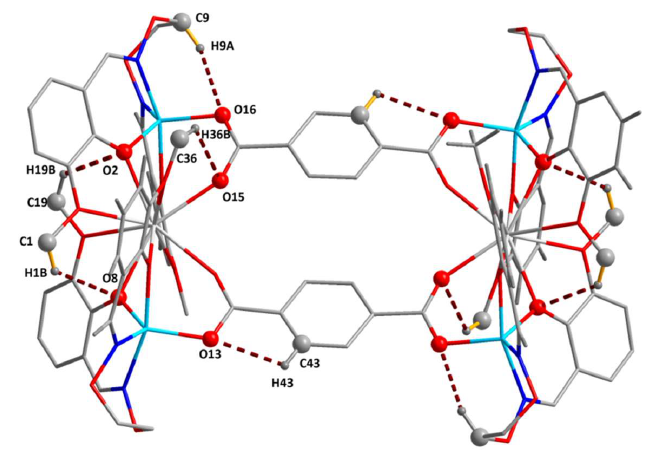
Figure 3. View of the intramolecular hydrogen bondings of the Zn II –Eu III complex. Table 4. Hydrogen bonding interactions (Å, °) of the Zn II –Eu III complex.